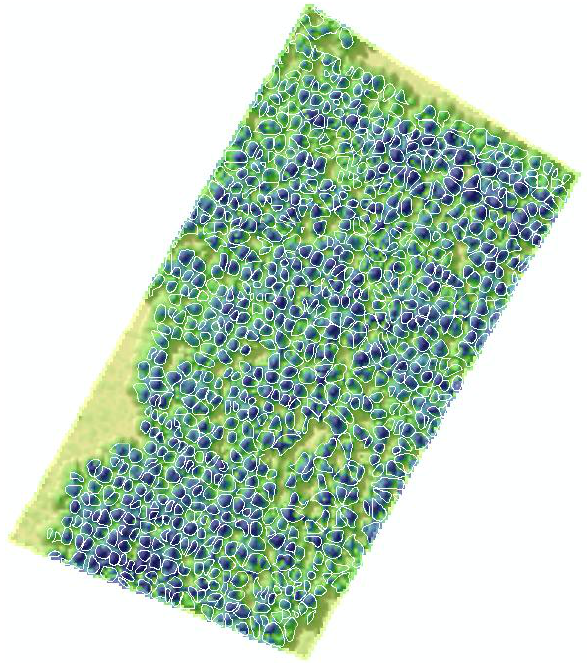
Figure 20. The final output overlaid in the CHM Most of the output of the proposed algorithm were able to accurately delineate tree crowns as shown in Figure 21.